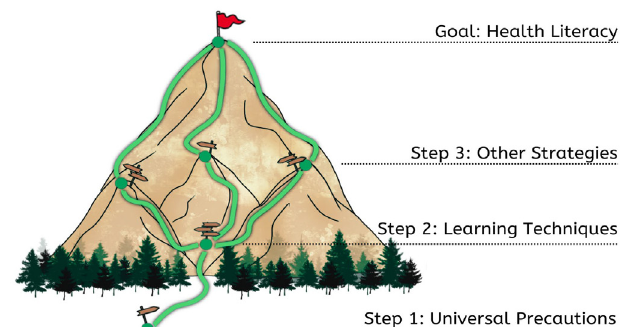
Figure 1. Approach for improving patient health